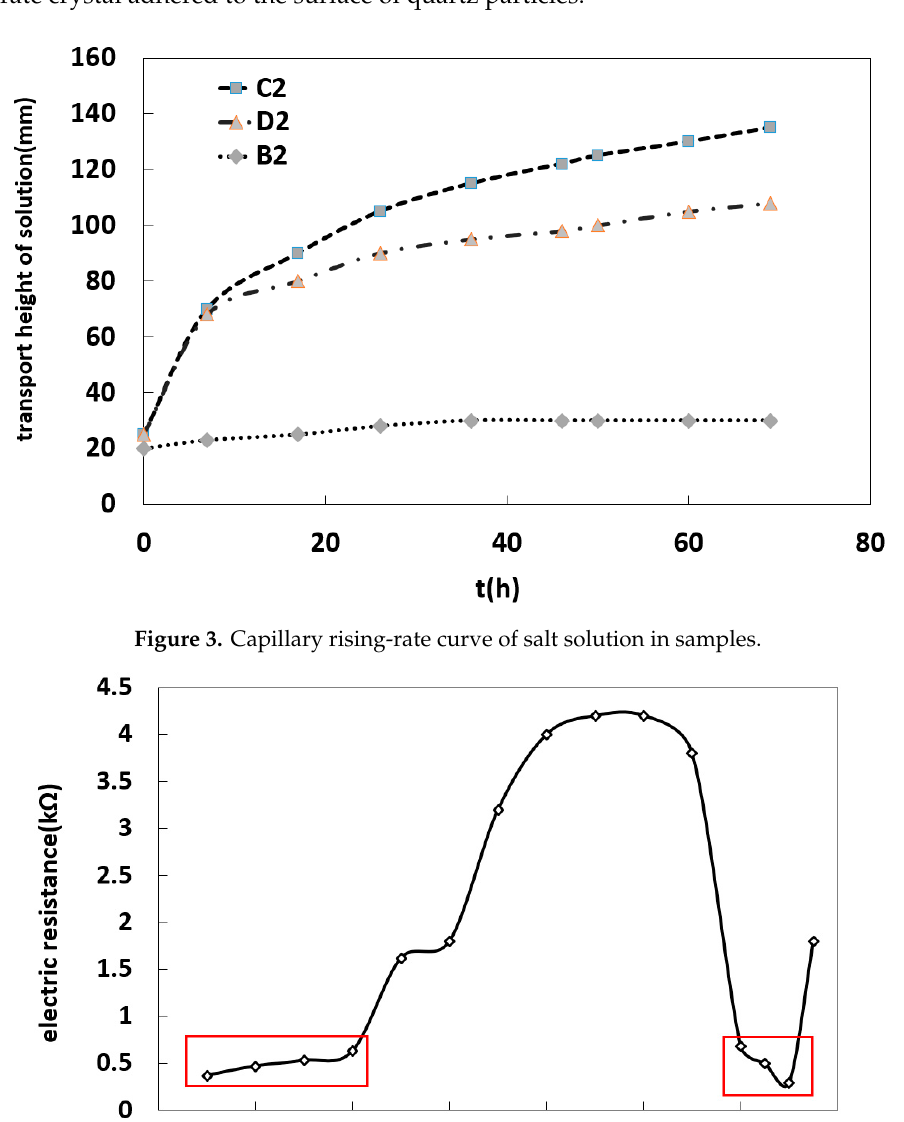
Figure 4. Solution resistance at different heights.